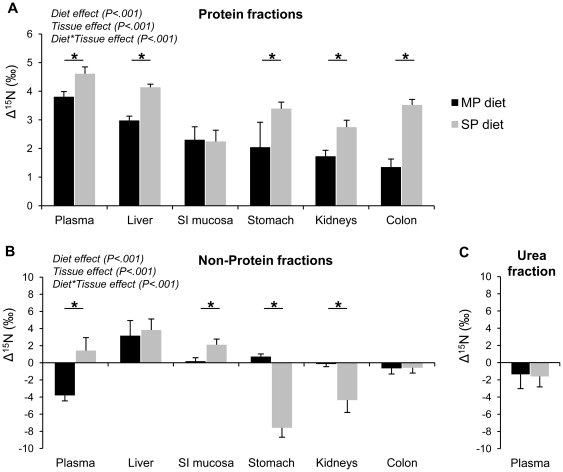
Nitrogen isotopic discrimination values (Δ15N) among the sampled tissues of rats.Δ15N of (A) tissues protein fractions (δ15Nprotein fraction−δ15Ndiet), (B) tissue non-protein fractions (δ15Nnon-protein fraction−δ15Ndiet) and (C) plasma urea (δ15Nplasma urea−δ15Ndiet), of rats fed the MP (black bars) and the SP (grey bars) diets. Values are means ± SD. *Effect of the dietary protein source in a given tissue (Post hoc tests with Tukey adjustments, P<0.001). All values are significantly different from 0 (Student t-tests, P<0.05) except for the non-protein fractions of SI mucosa and kidneys for the MP group. MP, Milk Protein; SP, Soy Protein; SI, Small Intestine.